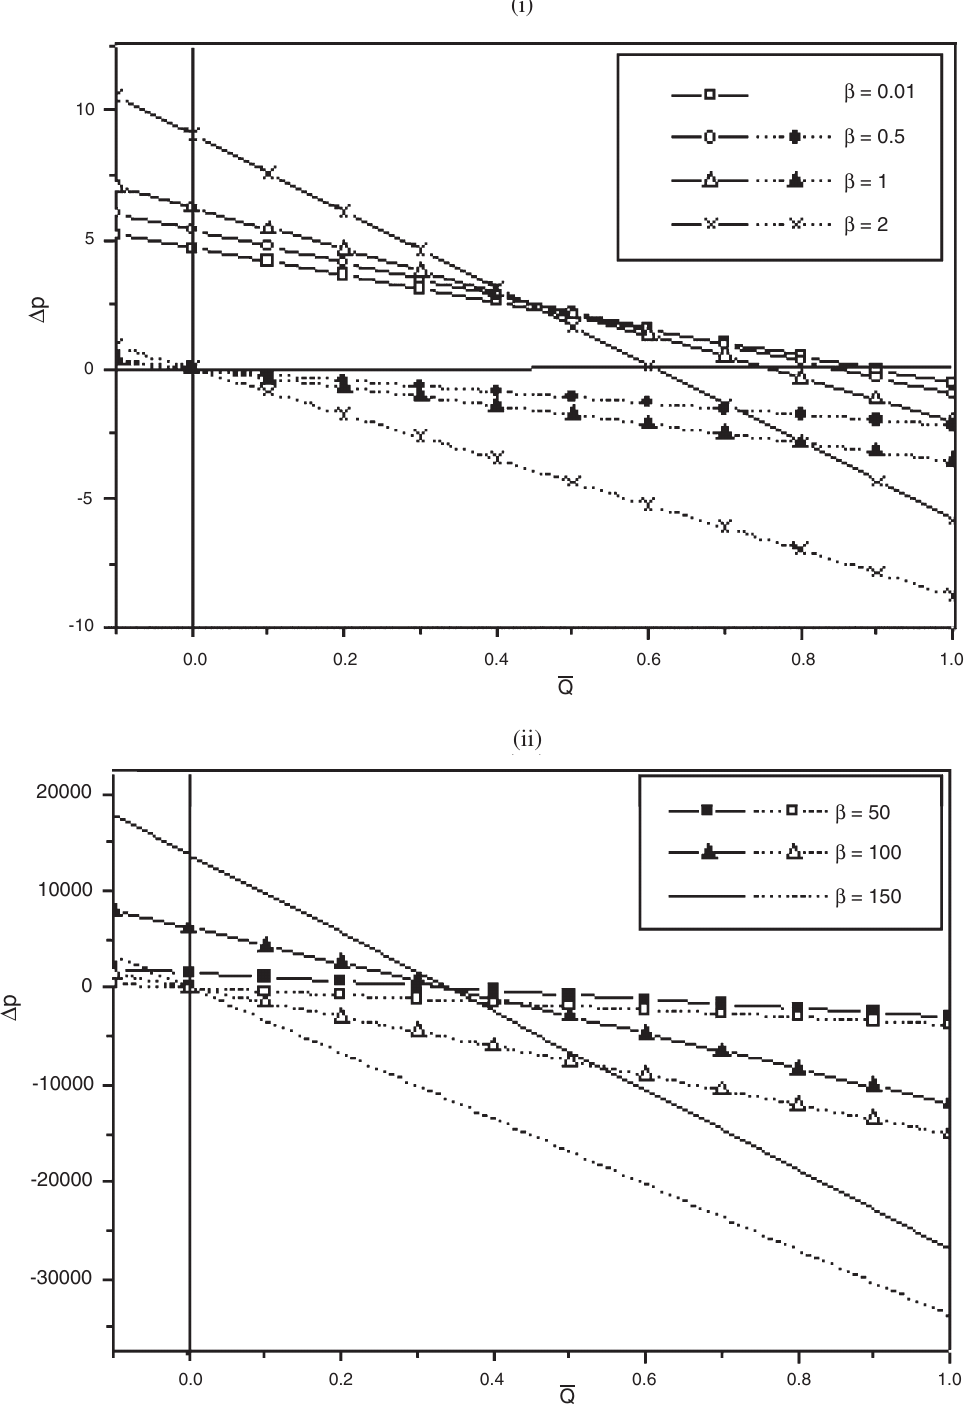
Fig.3. Variationof (cid:9) p verus Q with a = b = 0 . 6and φ = π/ 4 (i)forsmallvaluesof(ii)Forlarge β ,andthecorrespondinggraphsforPoiseuille ( a = b = 0) flow are given in dot